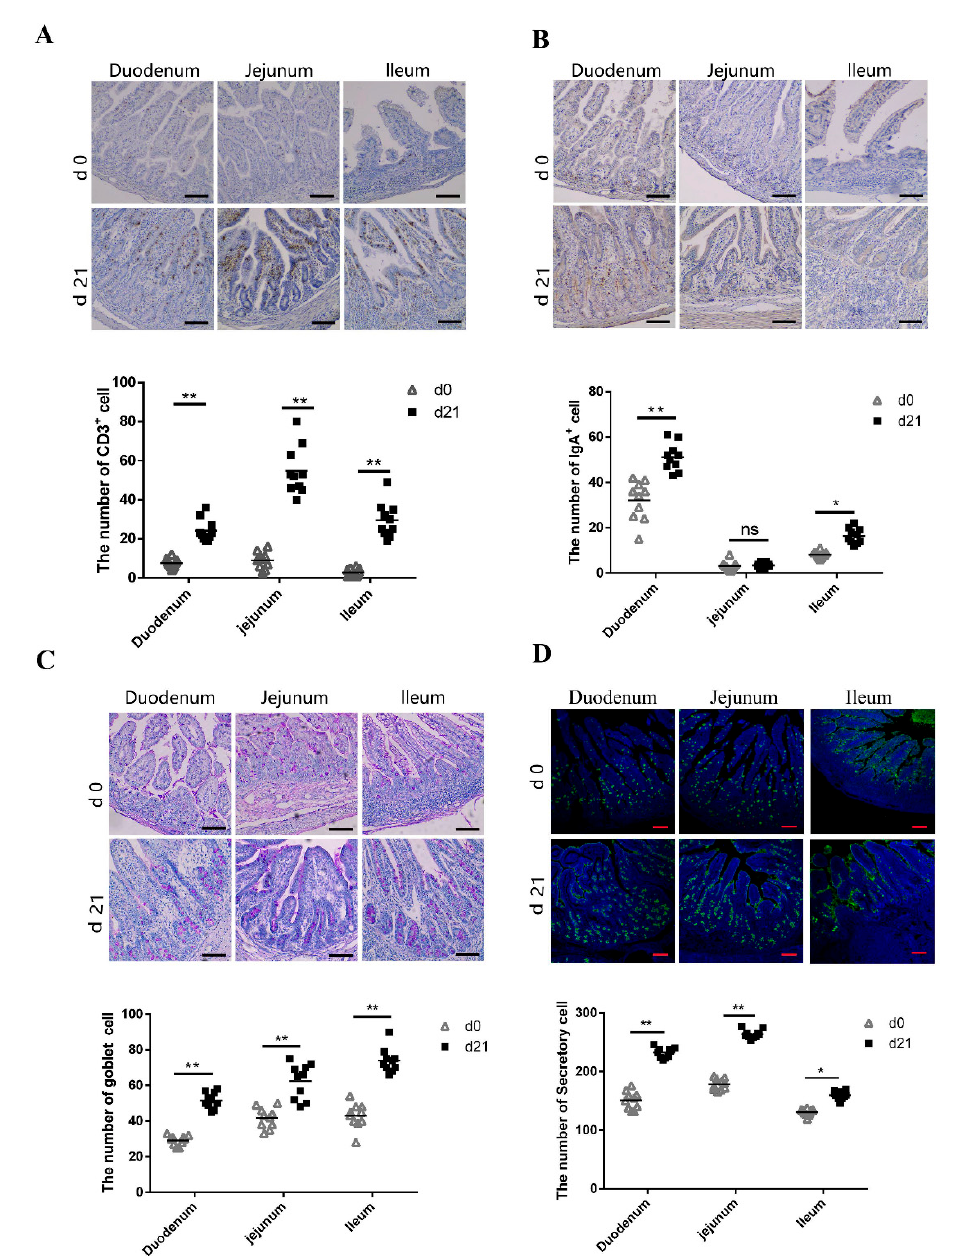
Figure 3. Expression of CD3 + T cells, SIgA-positive cells, goblet cells, and secretory cells in small intestines. ( A – C ) Immunohistochemical staining of CD3 + T cells, SIgA-positive cells, and goblet cells. ns: not significant. ( D ) Immunofluorescent staining of secretory cells in pig small intestine. Positive cells were quantified using densitometry analyses and were calculated in ten random fields. ( n = 10 per group). Scale bars: 100 μ m. * 0.01 < p < 0.05 and ** p < 0.01.